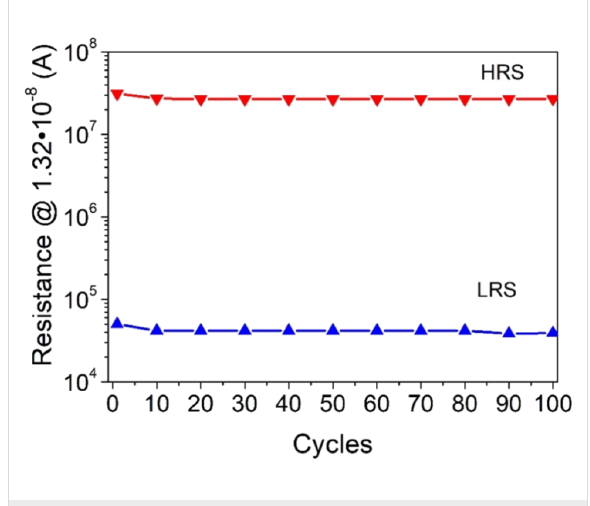
Figure 4: Retention characteristics for the Au/(Ti–Cu)Ox/TiAlV thin film structure.